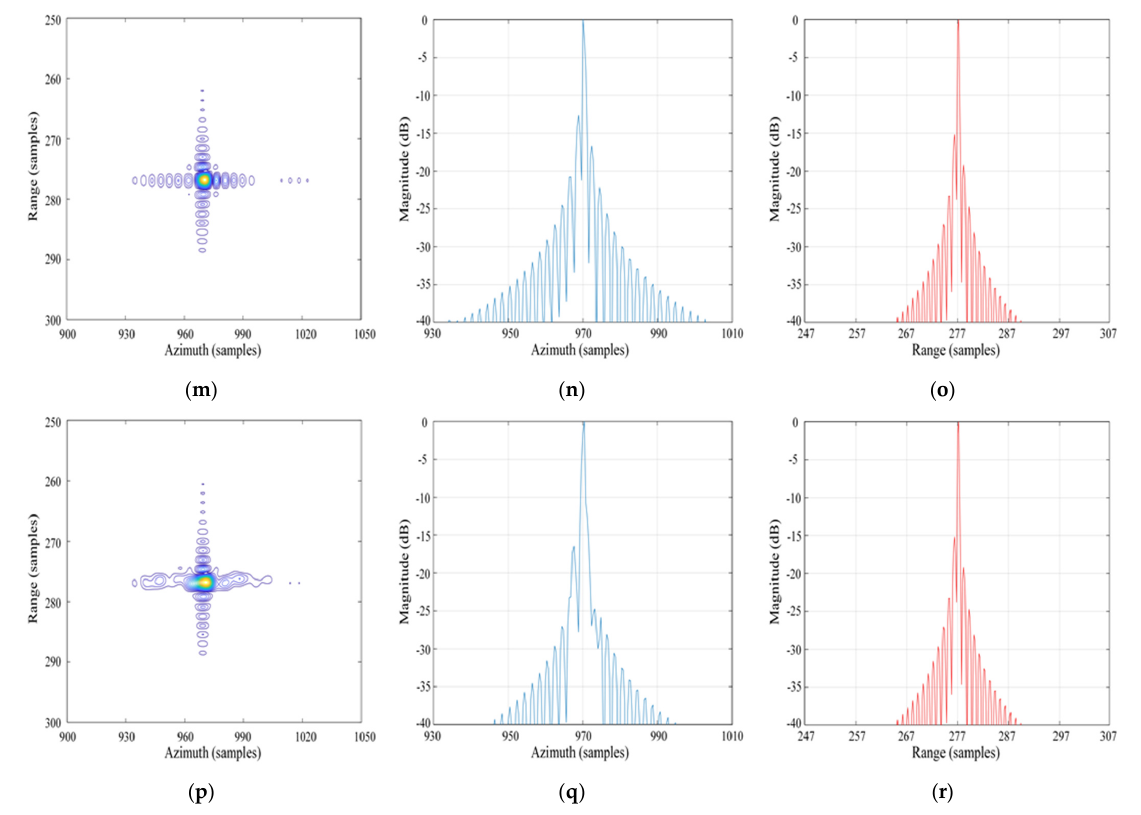
Figure 10. Detailed imaging results by the traditional NLCS and modified algorithm. ( a ) Contour plot of target 1 focused by the modified algorithm. ( b ) Azimuth impulse responses of target 1 by the modified algorithm. ( c ) Range impulse responses of target 1 by the modified algorithm. ( d ) Contour plot of target 1 focused by the traditional NLCS algorithm. ( e ) Azimuth impulse responses of target 1 by the traditional NLCS algorithm. ( f ) Range impulse responses of target 1 by the traditional NLCS algorithm. ( g ) Contour plot of target 3 focused by the modified algorithm. ( h ) Azimuth impulse responses of target 3 by the modified algorithm. ( i ) Range impulse responses of target 3 by the modified algorithm. ( j ) Contour plot of target 3 focused by the traditional NLCS algorithm. ( k ) Azimuth impulse responses of target 3 by the traditional NLCS algorithm. ( l ) Range impulse responses of target 3 by the traditional NLCS algorithm. ( m ) Contour plot of target 5 focused by the modified algorithm. ( n ) Azimuth impulse responses of target 5 by the modified algorithm. ( o ) Range impulse responses of target 5 by the modified algorithm. ( p ) Contour plot of target 5 focused by the traditional NLCS algorithm. ( q ) Azimuth impulse responses of target 5 by the traditional NLCS algorithm. ( r ) Range impulse responses of target 5 by the traditional NLCS algorithm.